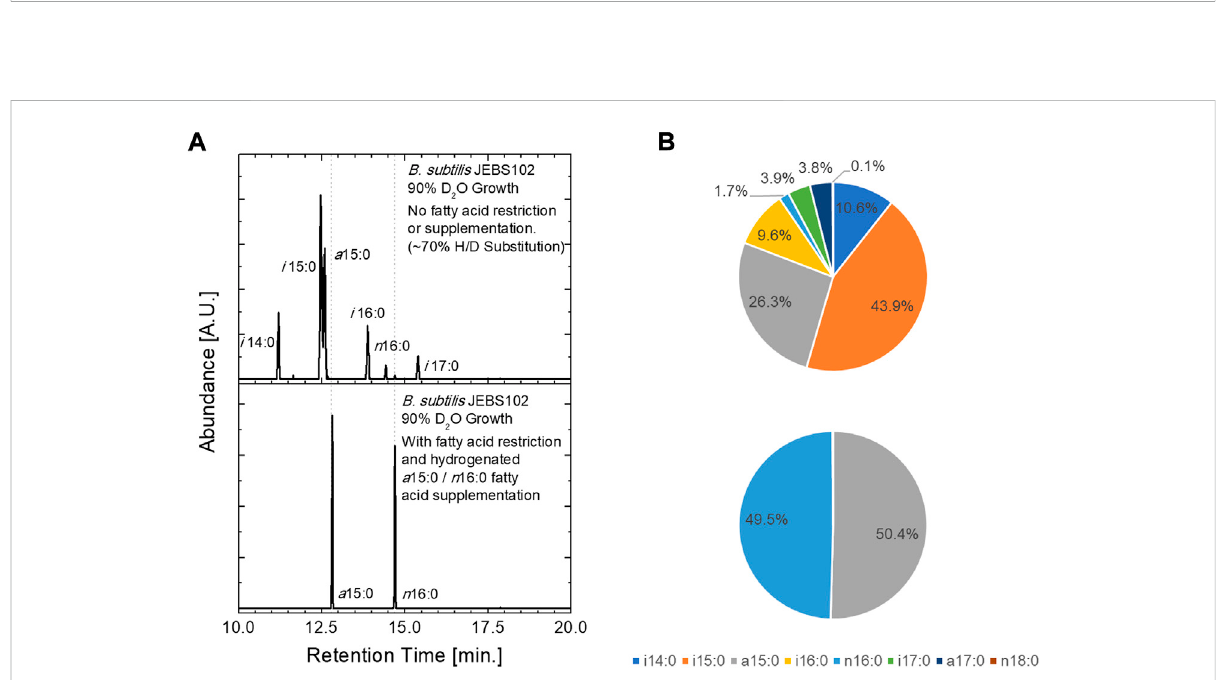
FIGURE 2 Fatty acid uptake was assessed using GC/MS analysis of extracted FAs from B. subtilis JEBS102 cells grown in 90% D 2 O growth conditions, with or without FA restriction and supplementation using the procedures described. (A) Chromatograms illustrate the presence of theseven native FAs in the upper panel and only the two supplemented FAs in the lower panel. Deuterium inclusion in synthesized FAs is indicated by both the decreased elution time and the broadening of the FAME peaks. The trace amounts of n 18:0 and n 16:0 are contaminants from release agents on plastic labware. (B) PiechartssummarizetheFAuptakedescribedin (A) .NotabledifferencesinFAuptakebetweenthecurrentconstruct andpriorworkcan be seen, namely a different ratio of i 15:0 to a 15:0 in the ‘ native ’ mixture of FAs in the uninduced cells and a far greater ratio of n 16:0 to a 15:0 in the induced and FA rescued